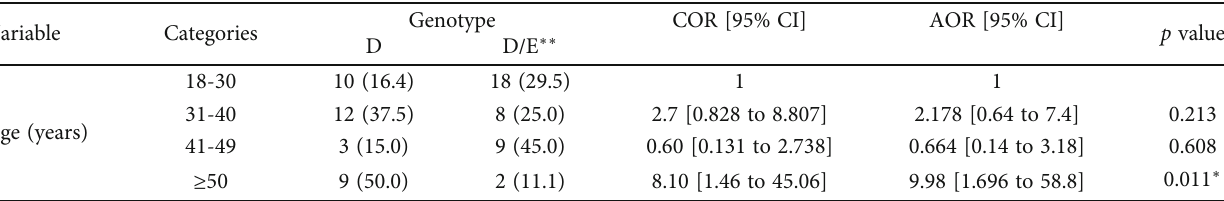
Table 5: Variation between age and genotype D distribution using multinomial regression analysis.